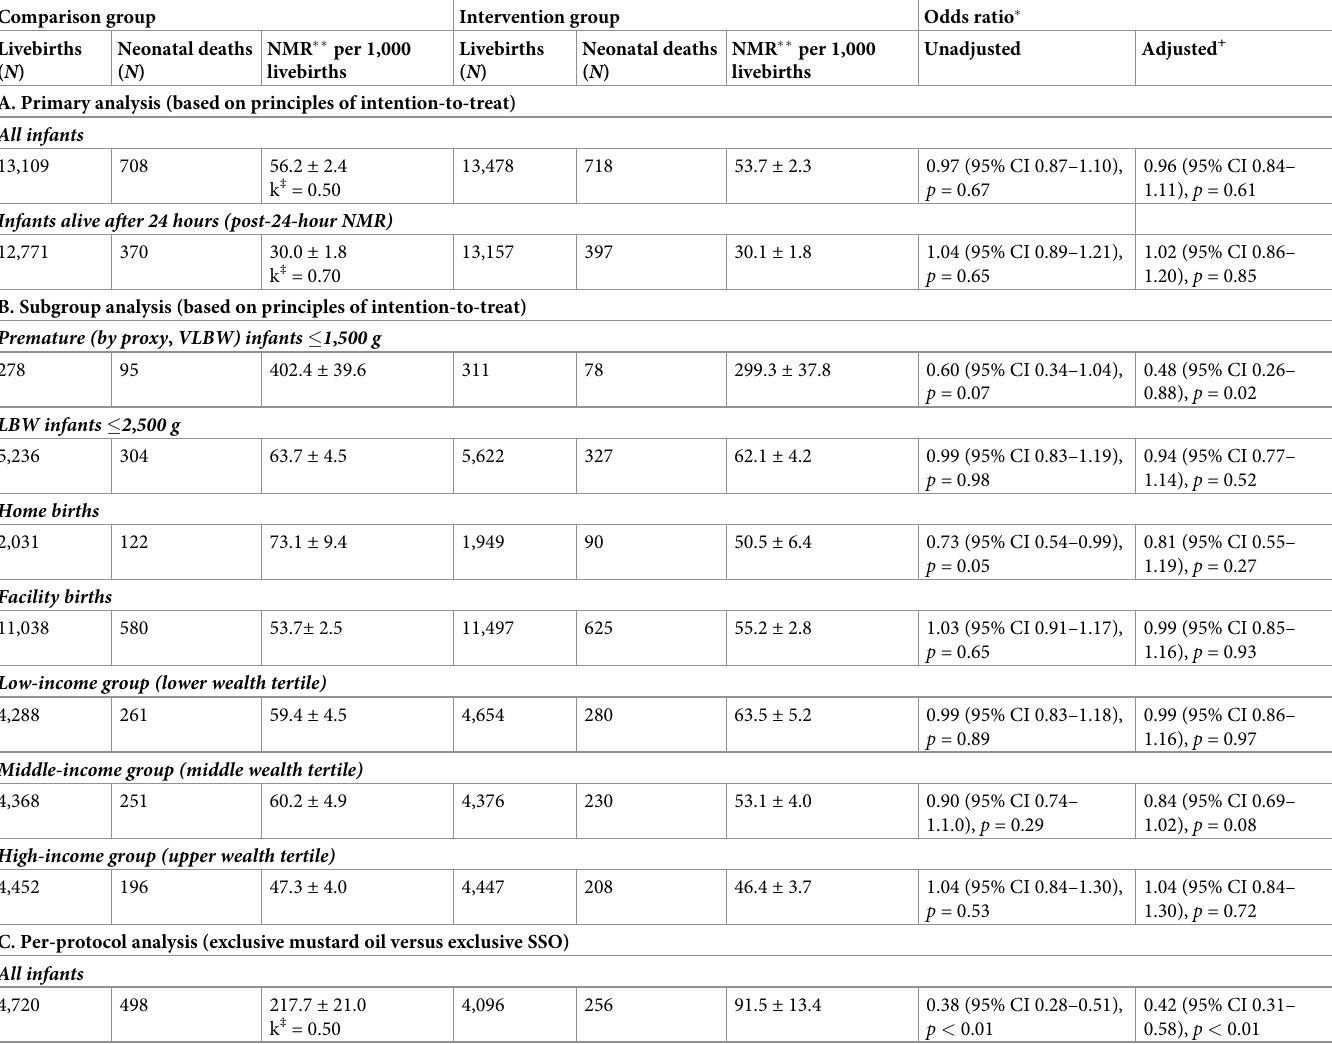
Table 2. Differences in (A) the primary outcome of NMR between intervention and comparison clusters of infants by intention-to-treat analysis, (B) NMR in sub- groups of infants in the intervention versus the comparison group by intention-to-treat analysis, and (C) NMR of infants in the intervention group treated exclu- sively with SSO compared to infants in the comparison group massaged exclusively with mustard oil (per-protocol analysis). Comparison